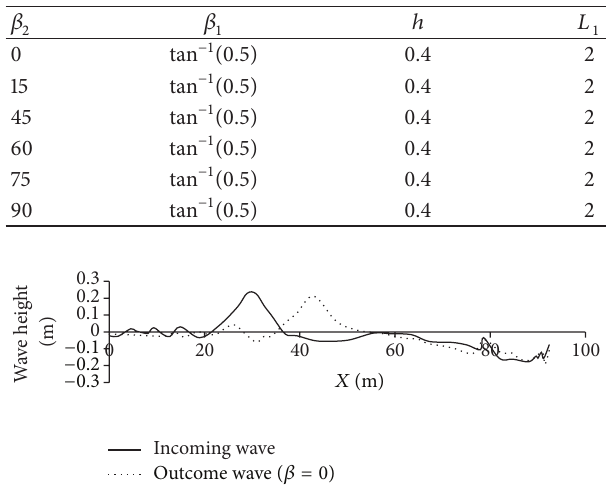
Figure 6: Free surface profile for 𝛽 2 = 0